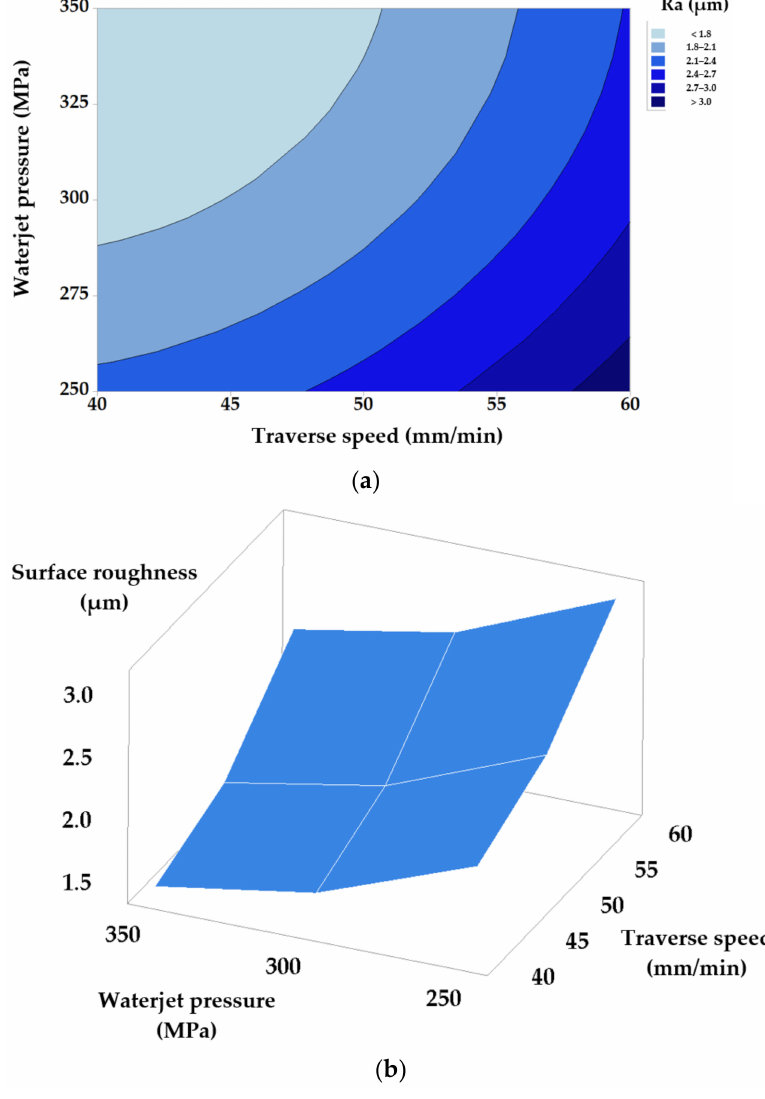
Figure 3. Roughness versus traverse speed and waterjet pressure set-point modification: ( a ) contour representation; ( b ) 3D